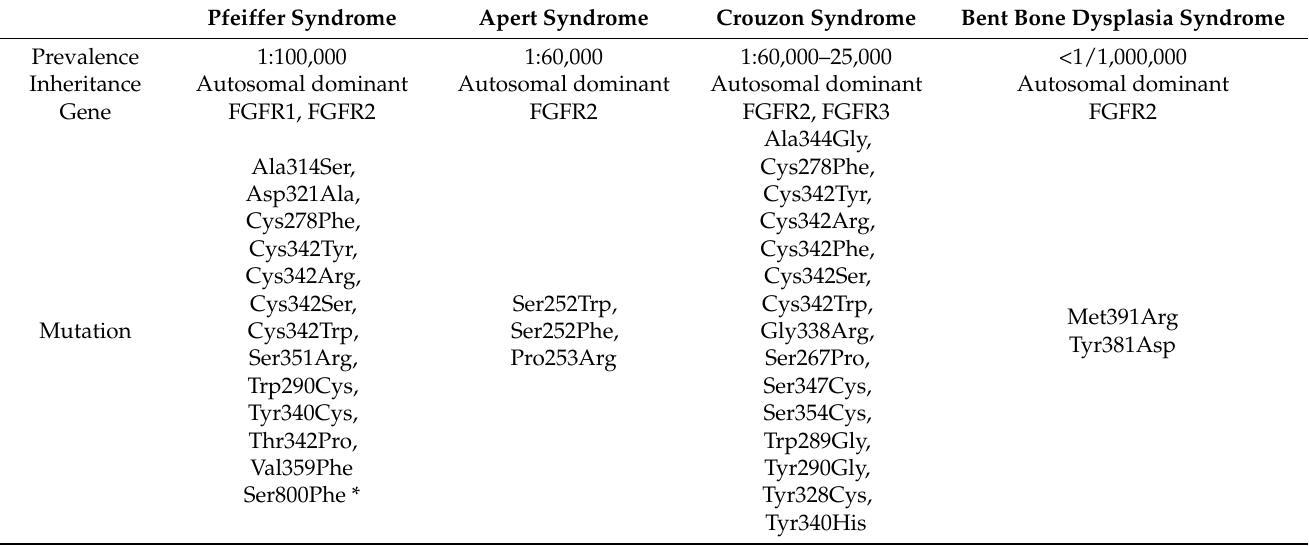
Table 1. FGFR2 mutation associated craniosynostosis syndromes with short stature ( * the